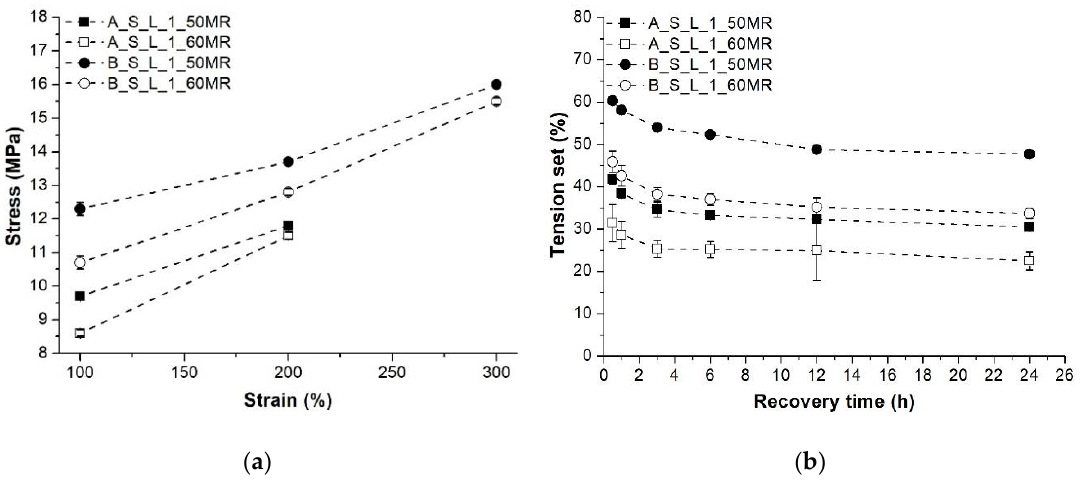
Figure 5. Stress at 100%, 200% and 300% elongation and the tension set of the TDVs produced with different screw configuration and MR content: ( a ) Stress; ( b ) Tension set.